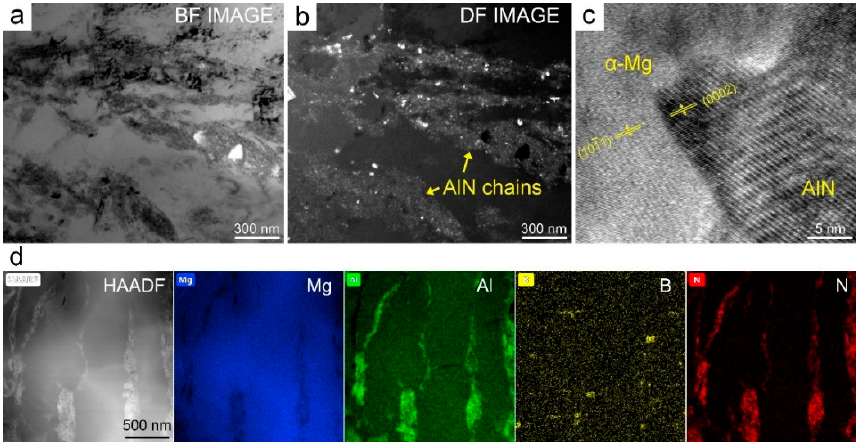
Figure 4. TEM analysis of the 8.2AlN in /Mg–8Al composite: ( a ) bright field image; ( b ) dark field image; ( c ) highly magnified picture and lattice image of AlN; ( d ) mapping of AlN chains.